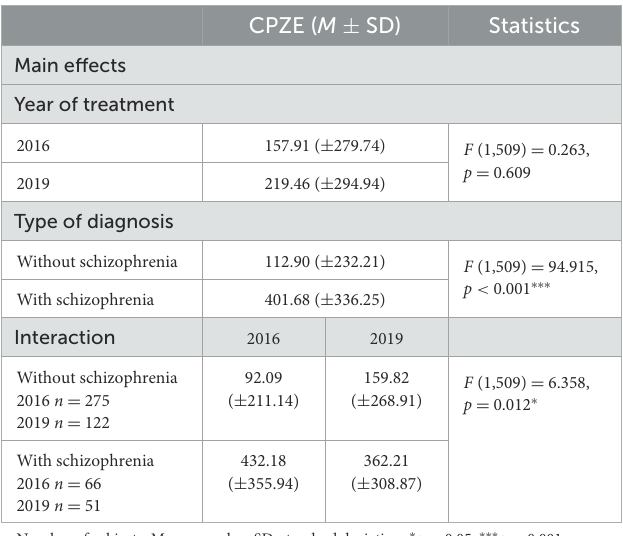
TABLE 4 Medication dosage at discharge in chlorpromazine equivalents (CPZE) (M ± SD) before and after the implementation of Soteria-elements.